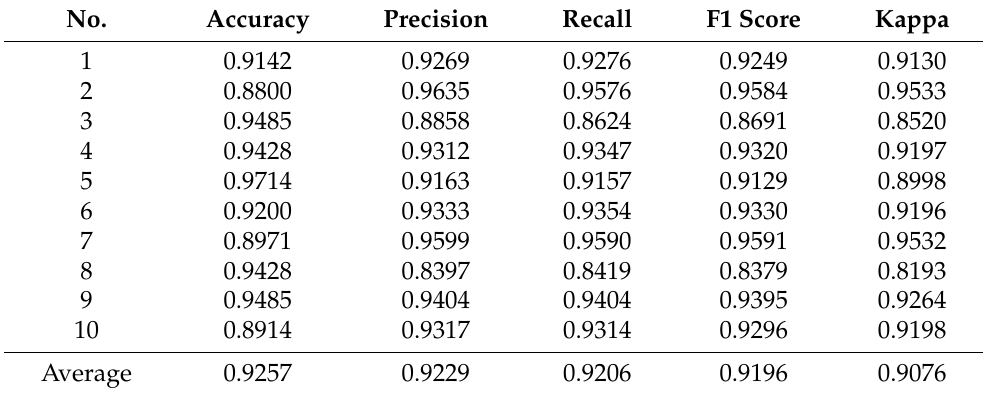
Table 4. Performance evaluation indexes for OLCE